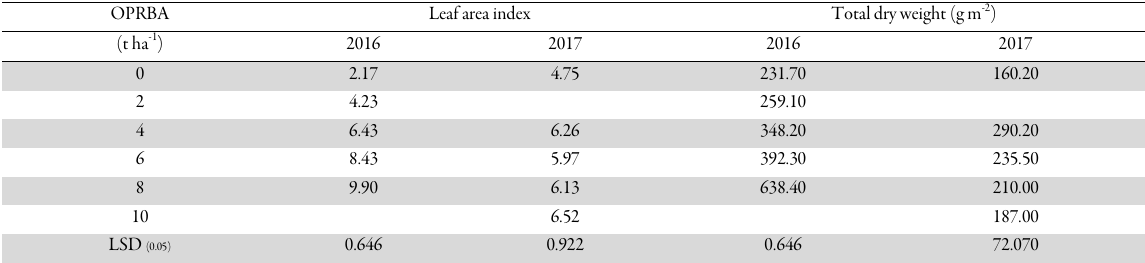
Table 3. Leaf area index and total dry weight of leaves of sweet potato as influenced by oil palm refuse bunch ash (OPRBA) OPRBA